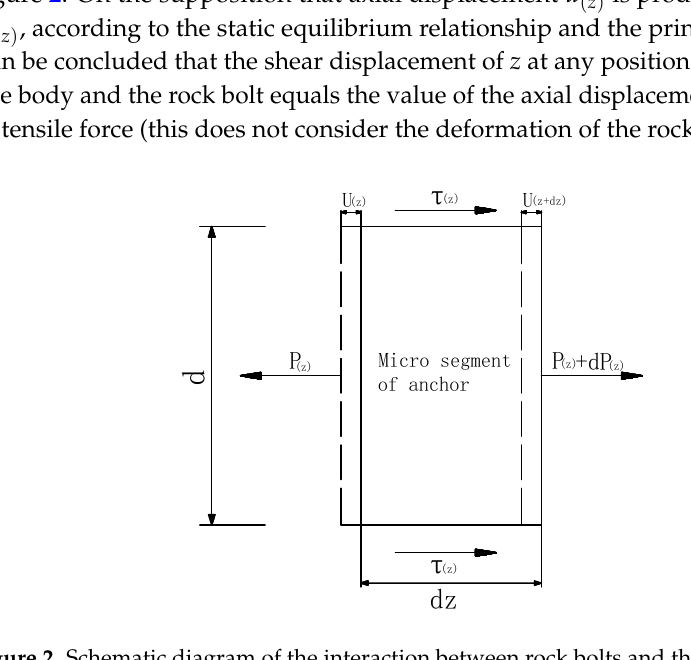
Figure 2. Schematic diagram of the interaction between rock bolts and the grouting body.